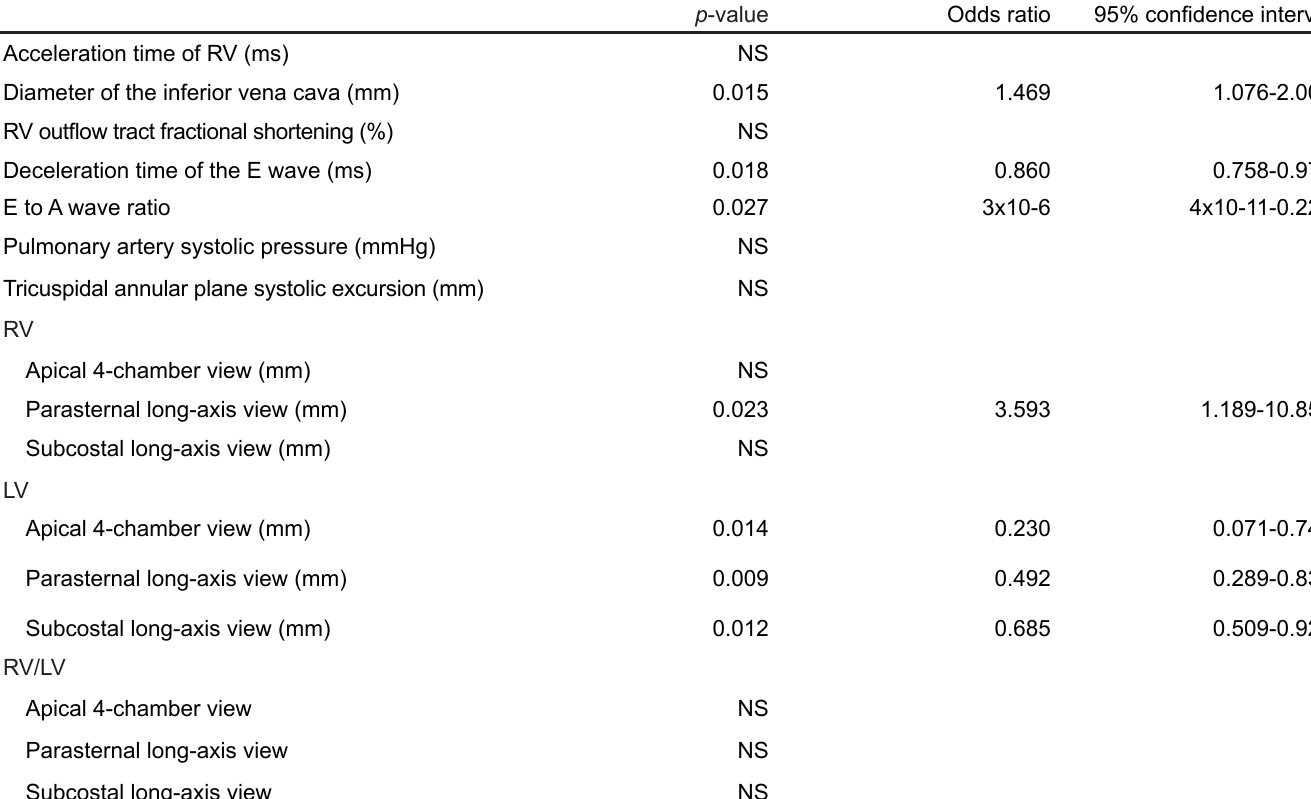
Table 4. Correlation according to the logistic univariate regression model of echocardiographic indices compared with the 7-day mortality, with relative p- value, odds ratio and confidence